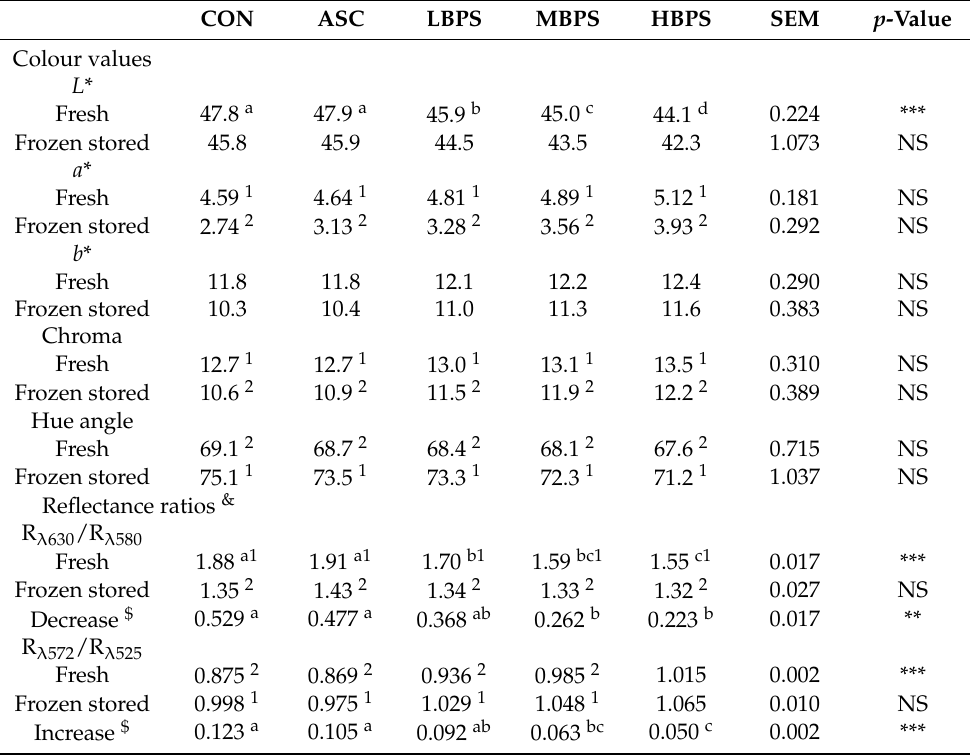
Table 3. Colour value and reflectance indexes of recently prepared (fresh) and frozen-stored # patties as a function of the type and amount of antioxidant used ( n =